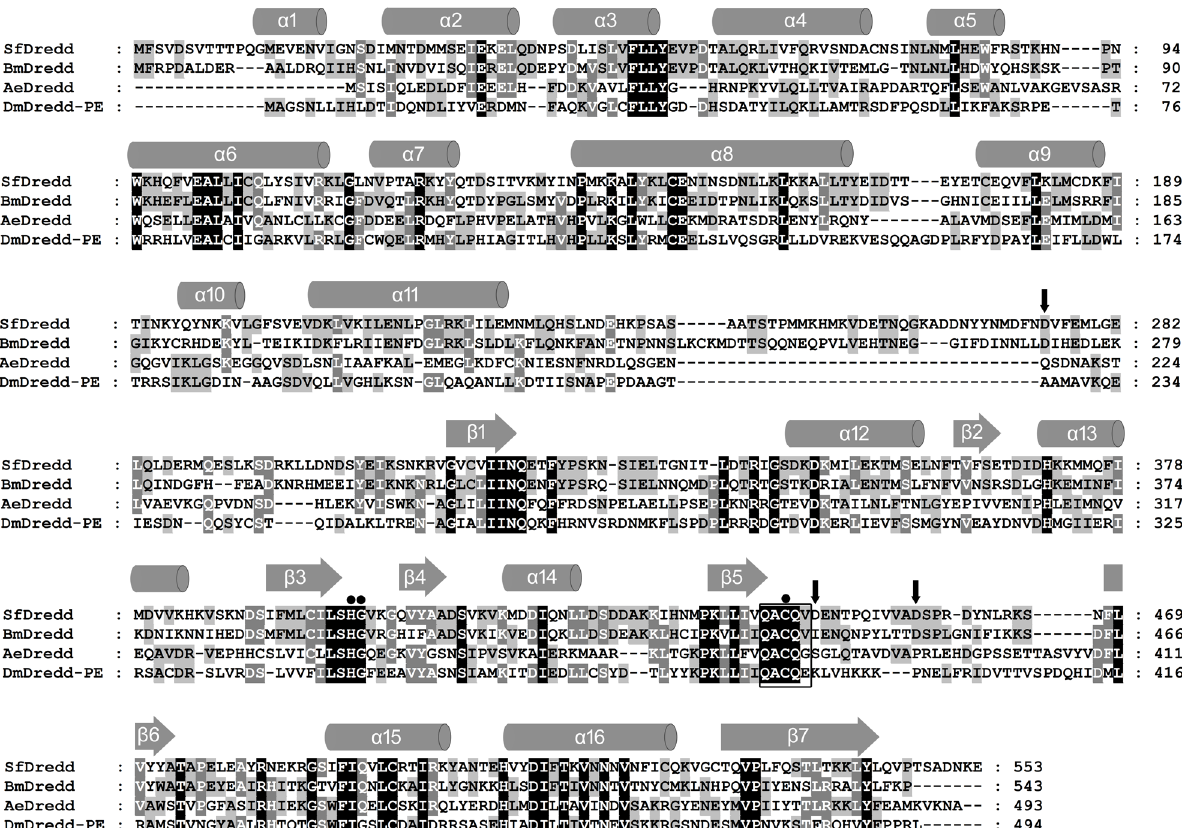
Fig 1. The sequence of SfDredd. The predicted amino acid sequence of SfDredd is shown in alignment with Dredd homologs from Bombyx mori (BmDredd), Aedes aegypti (AeDredd) and Drosophila melanogaster (DmDredd-PE). The amino acid residues identical among 4 Dredds are indicated by white letters within black boxes, the amino acid residues identical among 3 Dredds are indicated by white letters within dark gray boxes, and the amino acid residues identical between 2 Dredds are indicated by black letters within light gray boxes. The alignment was performed using ClustalX 2.1 and modified by GeneDoc 3.2. Secondary structures were predicted using JPred3. Box: catalytic center, closed circles: conserved residues responsible for the catalytic reaction, black arrow: predicted cleavage sites.